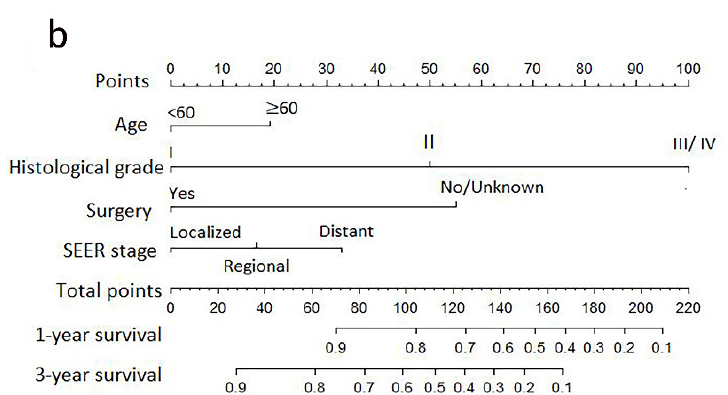
Figure 3. Nomogram to predict the 1-year and 3-year of the overall survival ( a ) and disease-specific survival ( b ) in primary bile duct and ampullary neuroendocrine neoplasms patients.